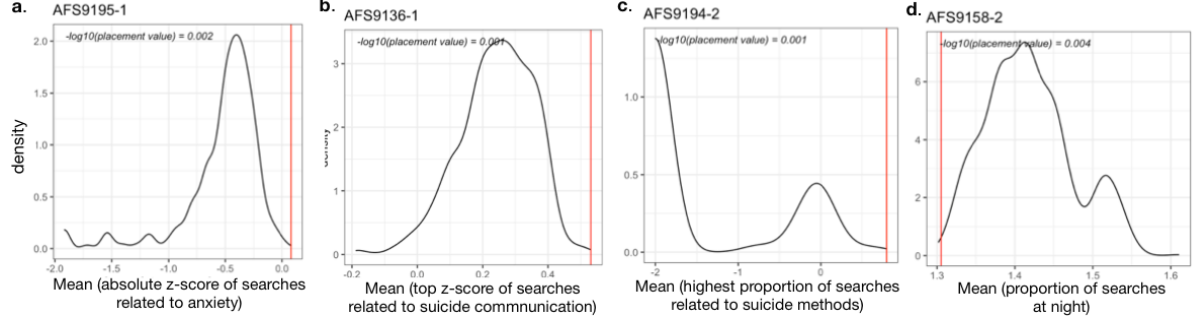
Figure 4. Baseline distributions for 4 example search features (each indicated by a red circle in Figure 3): (a) anxiety – 7-day proximal period; (b) suicide communication – 15-day proximal period; (c) suicide methods – 30-day proximal period; and (d) searches at night – 60-day proximal period. The red line indicates the value of the search feature in the corresponding time period proximal to a suicide